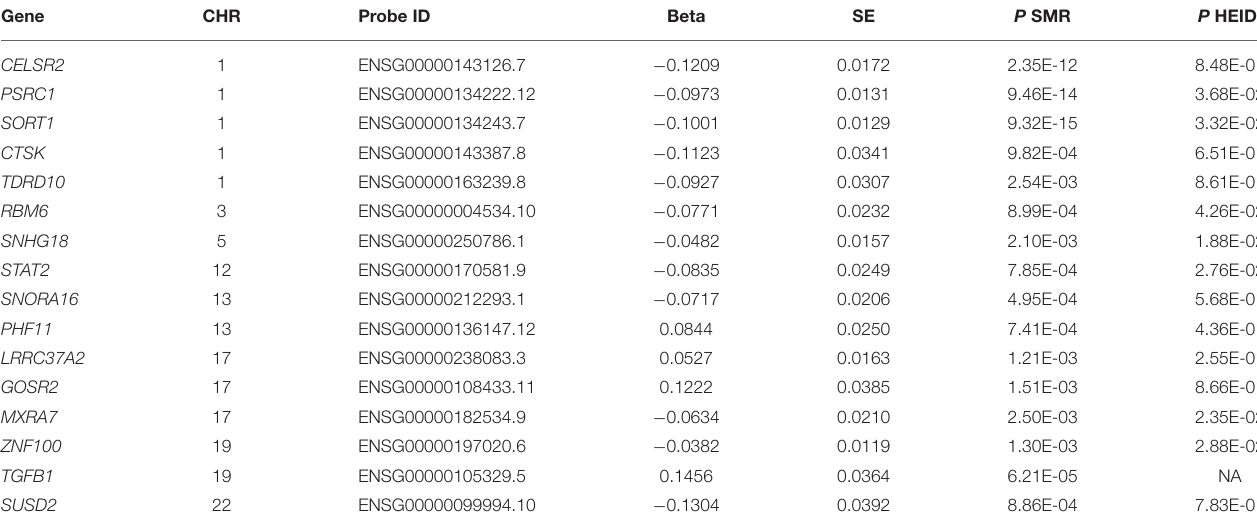
TABLE 1 | Liver cell gene expressions associated with CAD.